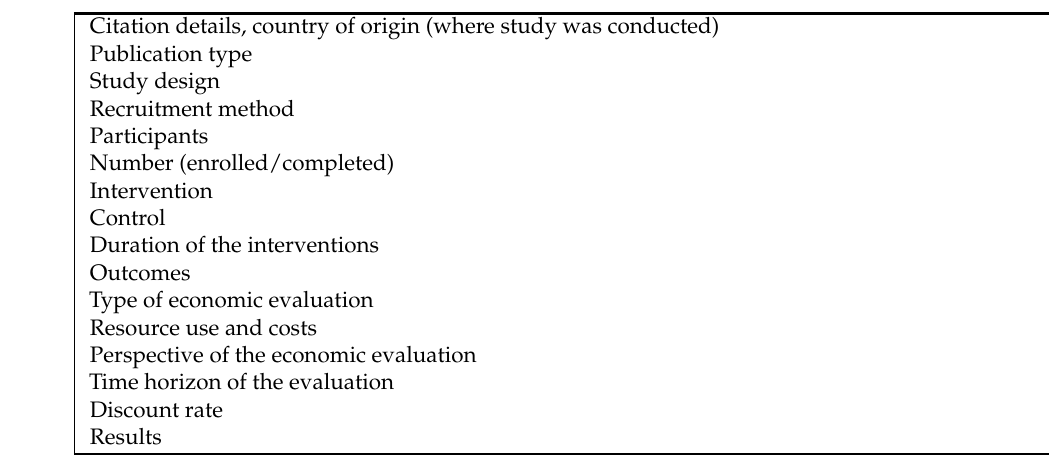
Table 1. Data extraction template.